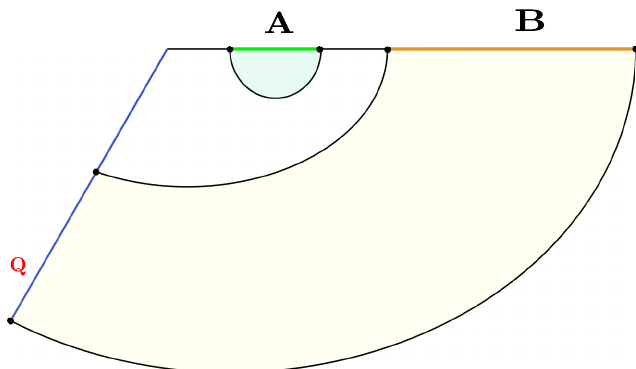
Figure 11. Schematics of the entanglement wedge cross section corresponding to phase-III con- formally mapped the static mirror setup. Figure modified from